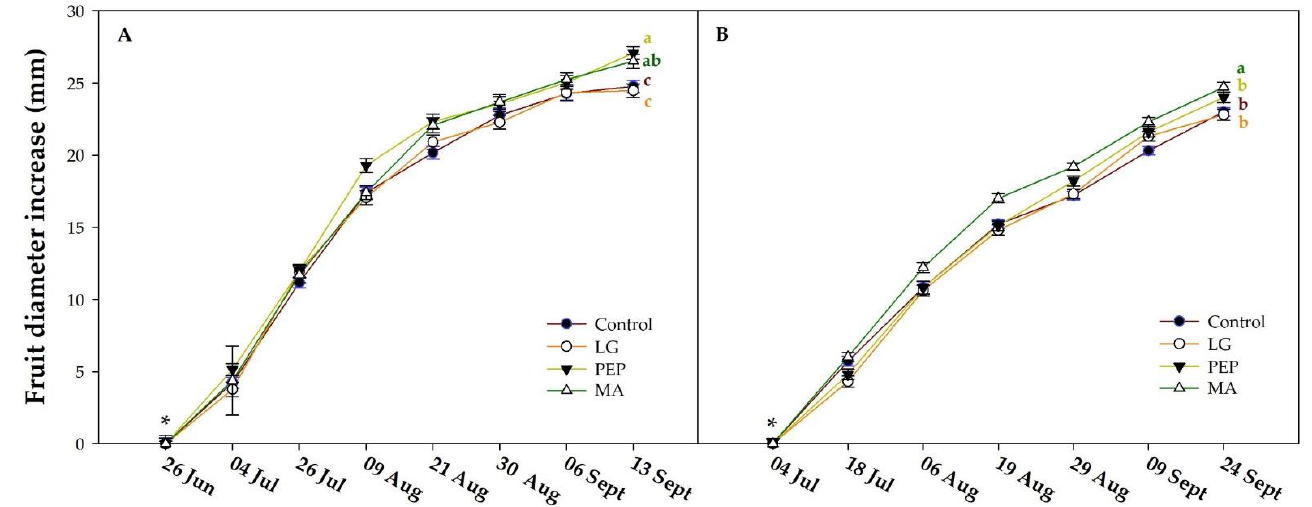
Figure 1. Effects of the biostimulants on the diametrical increase in the Annurca fruits during growing season 2018 ( A ) and 2019 ( B ). LG: seaweed mix + zinc + potassium; PEP: protein hydrolysates; and MA: microalgae. Vertical bars indicate ± SE of the means; n = 100 fruits. Different letters (a, b, and c) indicate significant differences according to Duncan’s multiple-range test ( p = 0.05), the letters have the same color of treatment curve. * indicate the first application of the biostimulants.